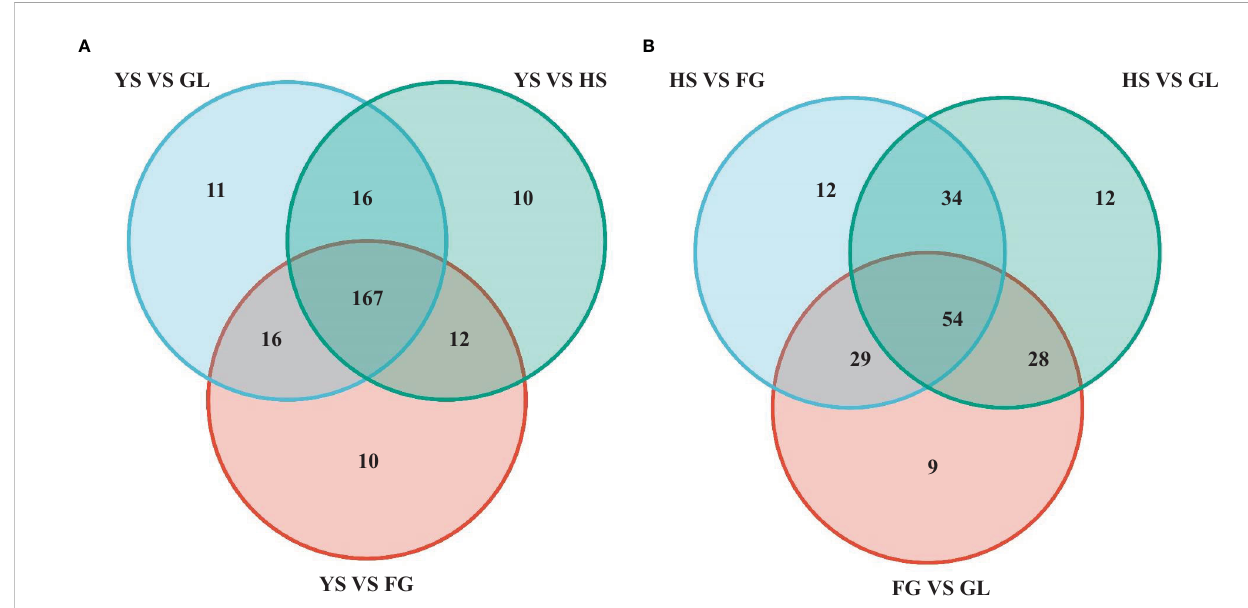
FIGURE 4 Venn diagram of common differentially accumulated metabolites. HS, FG, GL, P. thomsonii varieties; YS, P. lobata variety. (A) Common differentially accumulated metabolites in comparisons of P. lobata and each P. thomsonii variety. (B) Common differentially accumulated metabolites in comparisons of the three P. thomsonii